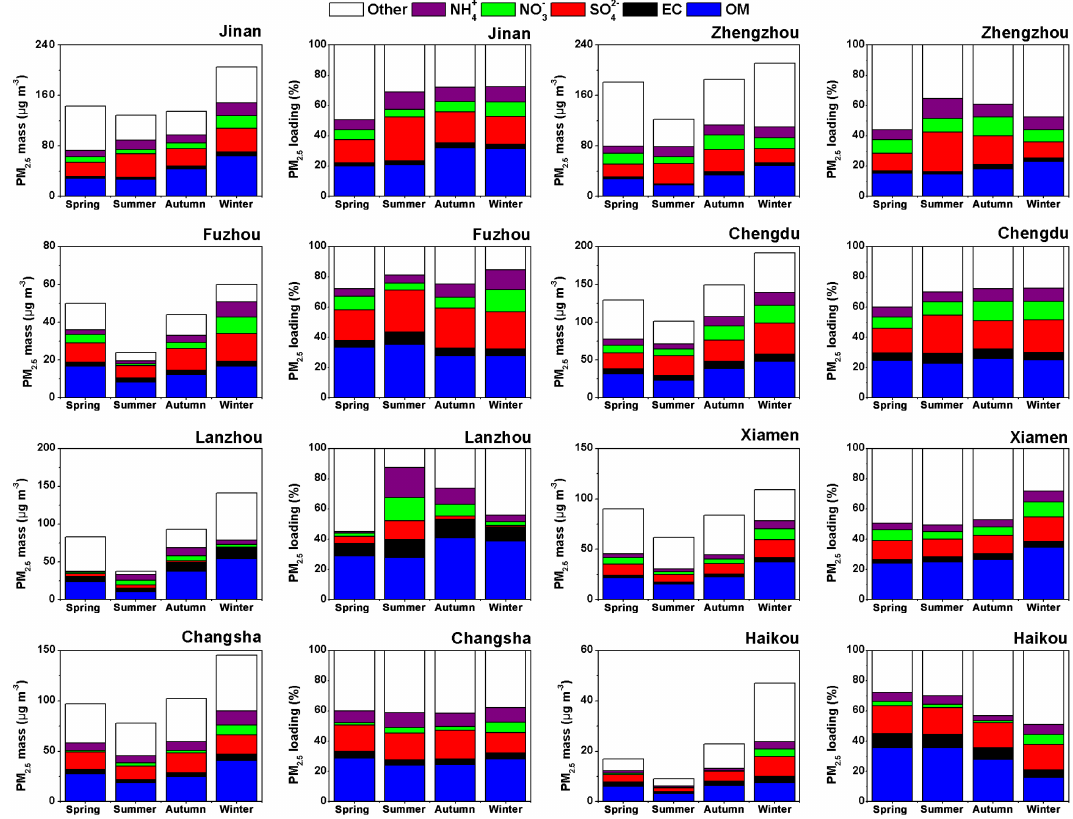
Figure 7. Seasonal PM 2 . 5 and dominant chemical components in other cities.